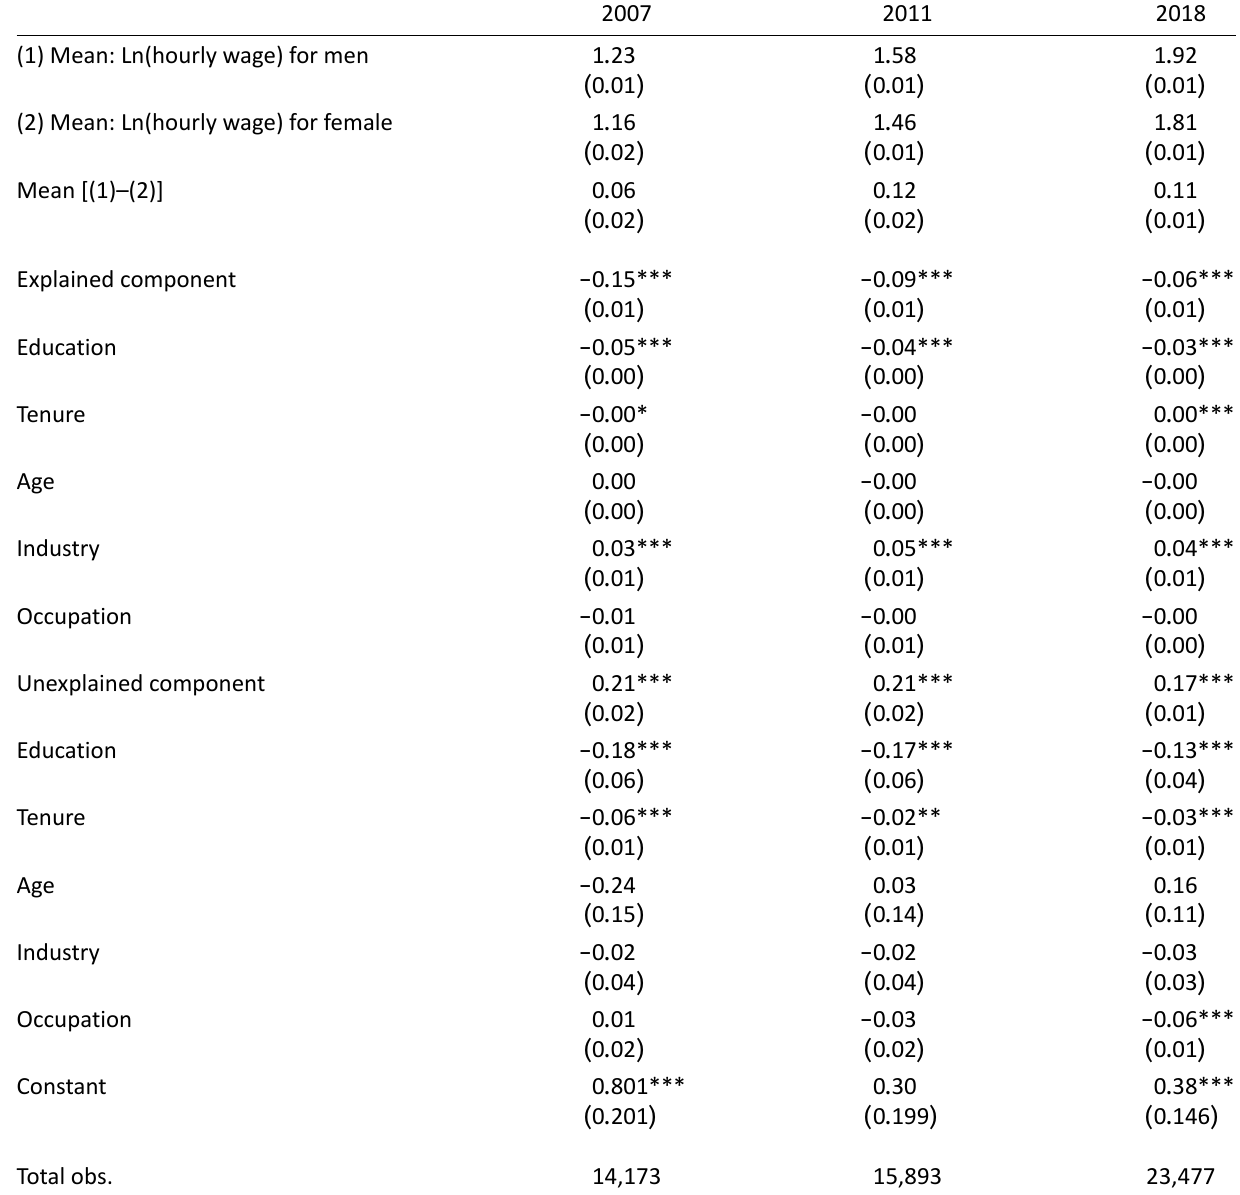
Table 3. Oaxaca‐Blinder